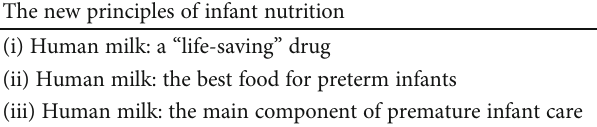
The new principles of infant